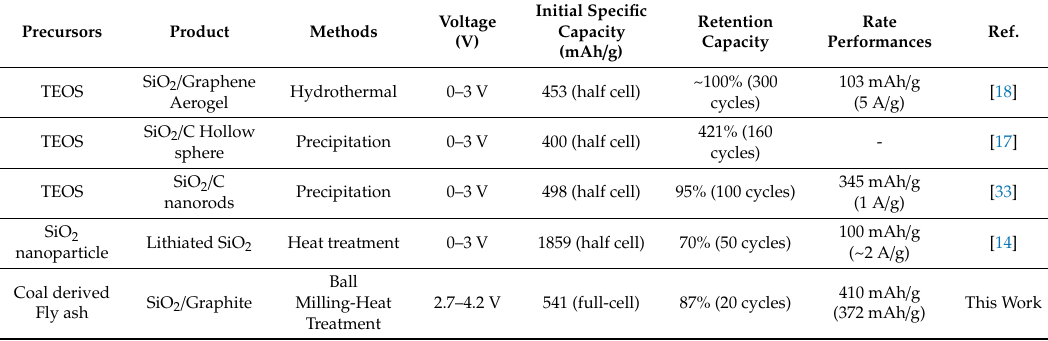
Table 4. Comparative study of SiO 2 based anode electrochemical